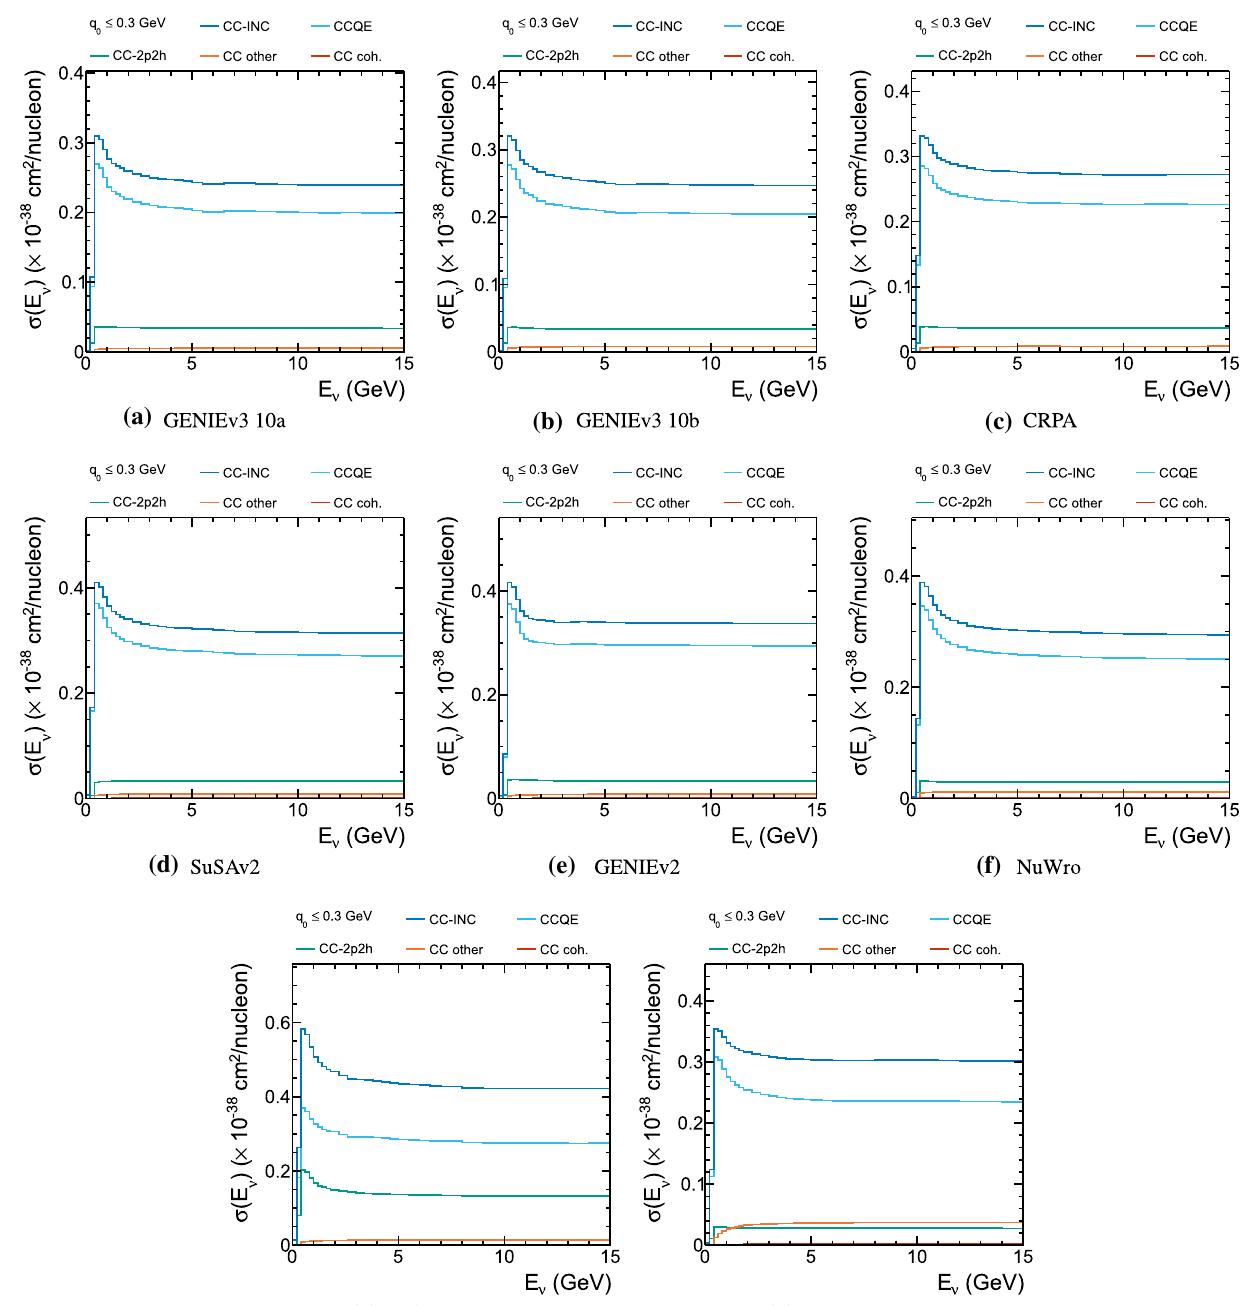
Fig. 2 Contributions to the charged-current cross section with q 0 ≤ 0 . 3 GeV as a function of E true ν for ν μ – 40 Ar and a variety of generator models, generated with a flat neutrino flux. Contributions from separate interaction channels are also